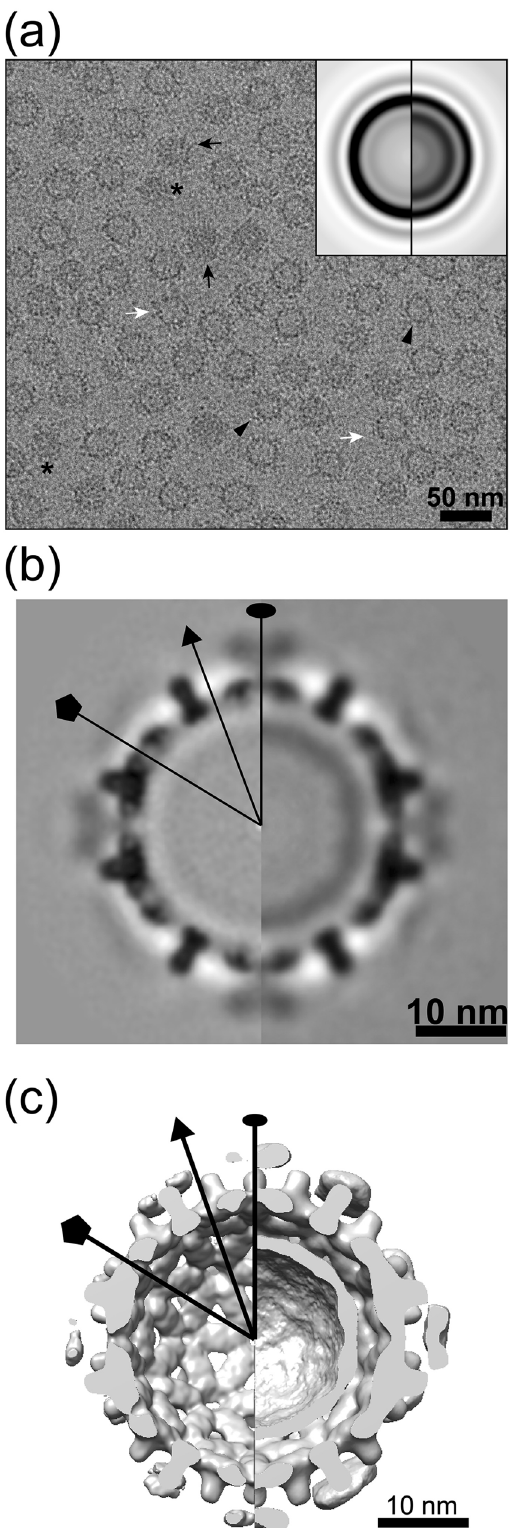
Fig 7. Cryo-EM reconstructions of Cp183-Imp β complex in ammonium formate. The sample was prepared with 11 μ M dimer concentration for Cp183 capsid and 18.8 μ M Imp β , a ratio of 205 Imp β per capsid. The sample was dissolved in 0.15 M ammonium formate buffer. (a) Typical cryo-EM micrograph of